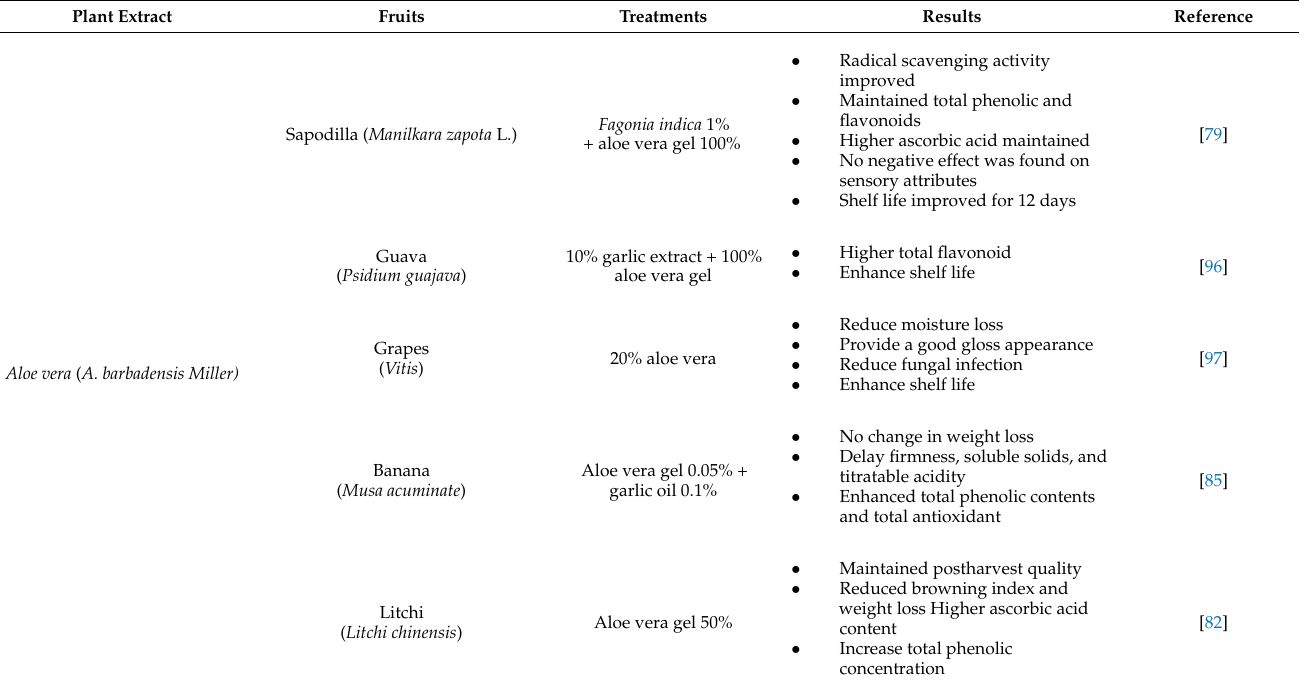
Table 1. Plant extracts’ effect on postharvest